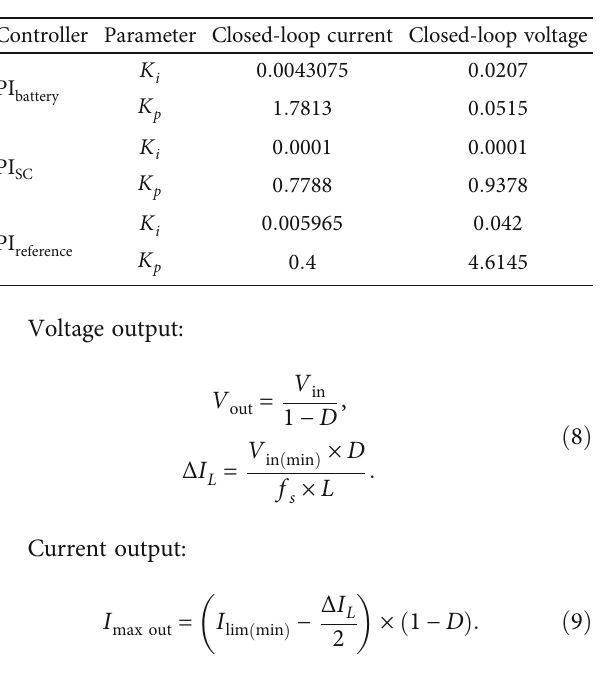
Figure 5: Control system of P&O. Table 2: Parameter of PI